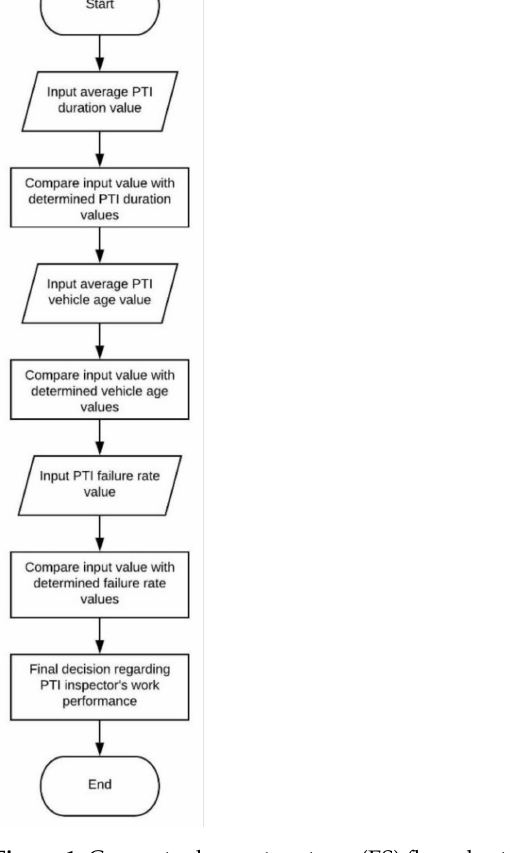
Figure 1. Conceptual expert systems (ES) flow